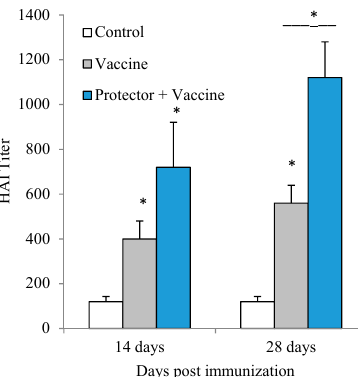
Figure 4. Oral administration of “Protector” increased HAI titer following Vaxigrip primary and secondary immunizations period. Mice received either single s.c. injection of Vaxigrip (5 µ g/mouse) at day 1, or two at days 1 and 14. Control mice injected with sterile PBS. Protector was orally administered for 1 week (375 µg × 3/day) for the single immunization group or for 2 weeks (one week apart) for the secondary immunization group (* p < 0.05 in comparison to the control and the bar represents the difference between the adjacent groups).